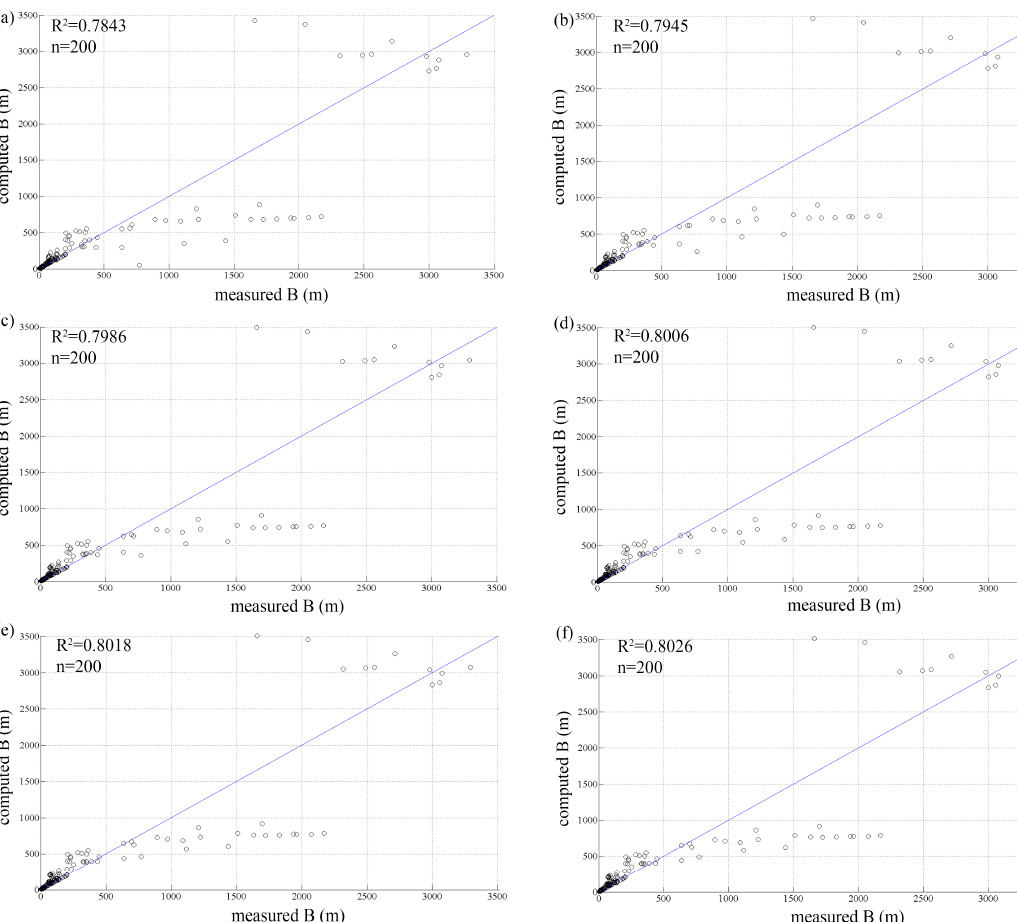
Figure 4. Comparison between computed and measured active river width B for different growth rates ( r) : ( a ) r = 0.010; ( b ) r = 0.015; ( c ) r = 0.020; ( d ) r = 0.025; ( e ) r = 0.030; ( f ) r = 0.035.